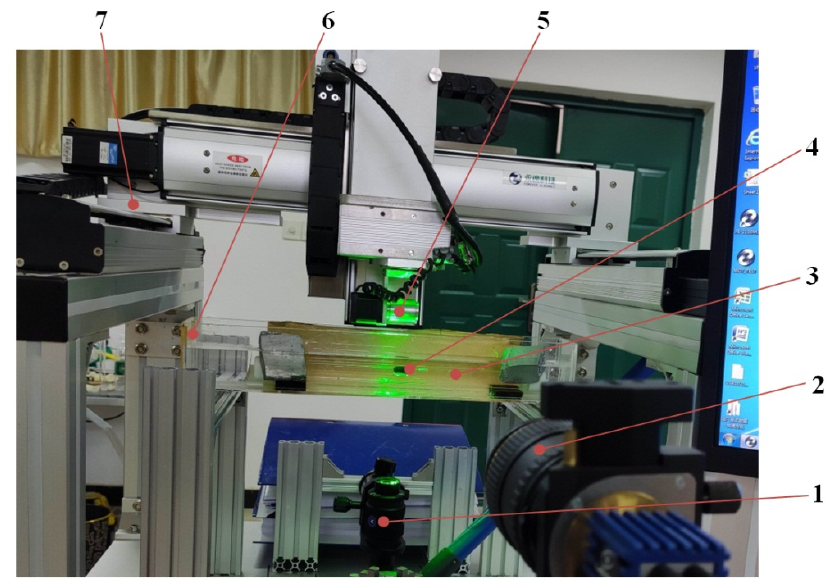
Figure 5. Measurement principle diagram of fluid flow field in the pipe of the capsule robot.